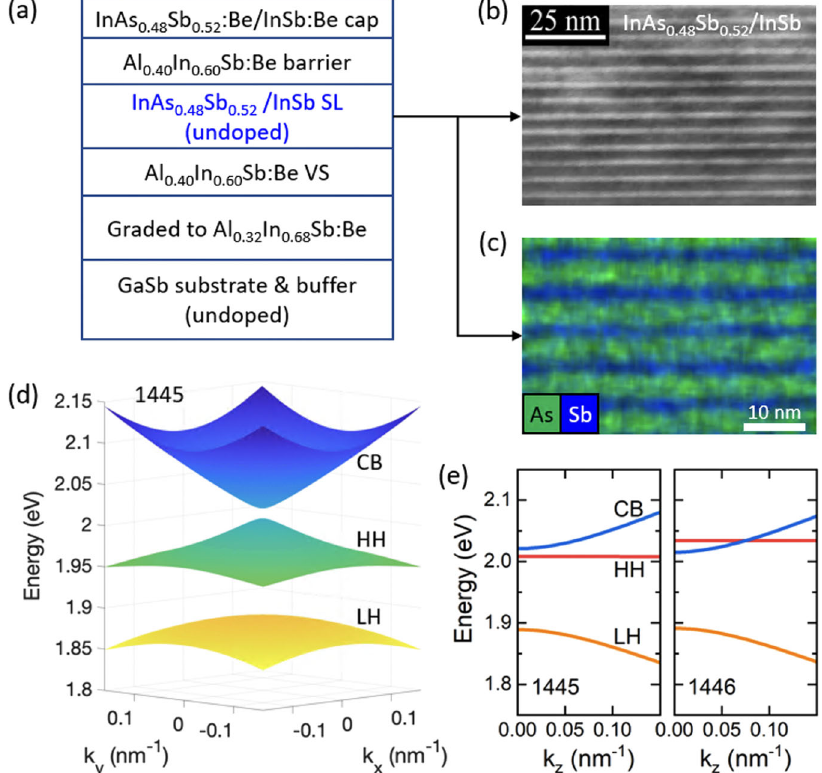
Fig. 1 | Structural characterization and zero- fi eld band structure